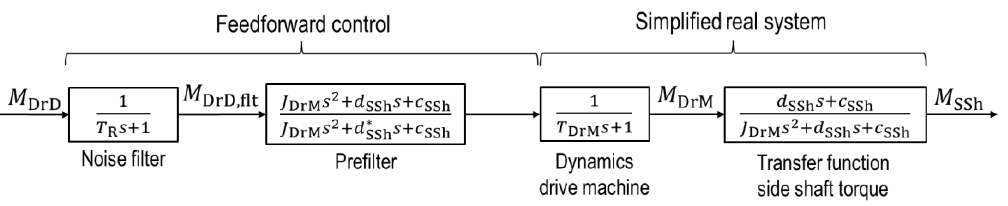
Figure 9. Signal flow diagram of the prefilter and the simplified real system.